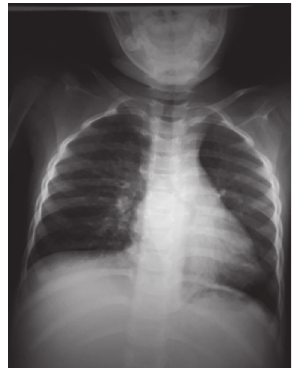
Figure 1: Immediately after operation puffiness of the eyelid, face, and chest.